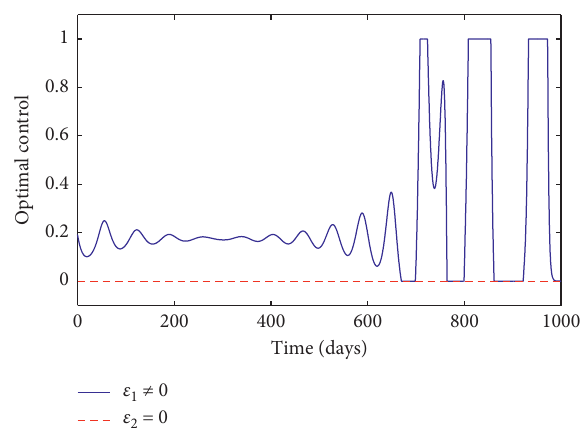
Figure 4: Optimal control strategy with ε